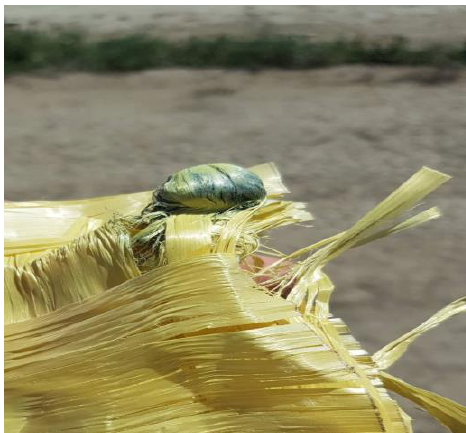
Fig.6: Ballistic test by AK47 with bullets of7.62*51